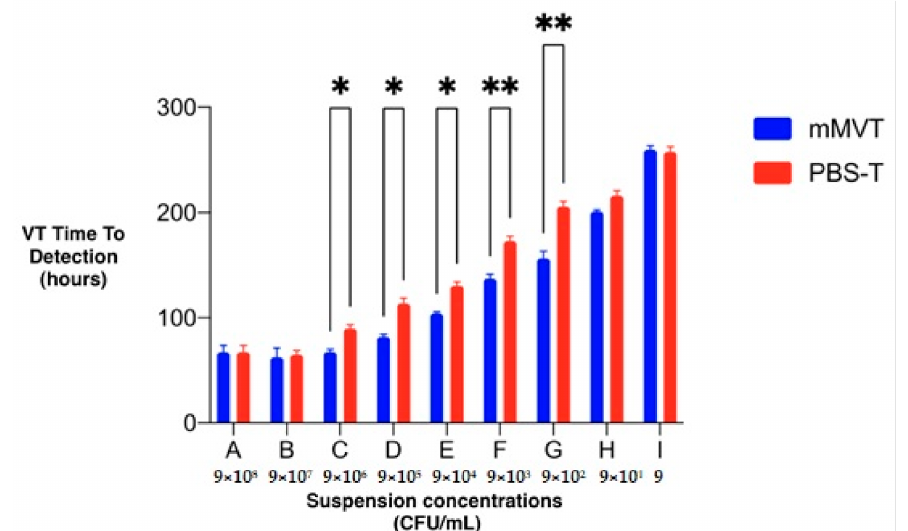
Figure 1. Bonferroni’s post-hoc test revealed a significant difference in positivity time of detection between suspension concentrations (A–I) and liquid media (mMVT vs PBS-T). Bars (mean ± standard deviation) indicate the positivity time for detection of M. chimaera by VT and asterisks indicate significant differences (* p < 0.05; ** p < 0.01). mMVT denotes VT Myco Media (modified Middlebrook 7H9 Broth, Trek Diagnostic System, Thermo Fisher Scientific); PBS-T phosphate-buffered saline added with 0.5% Tween